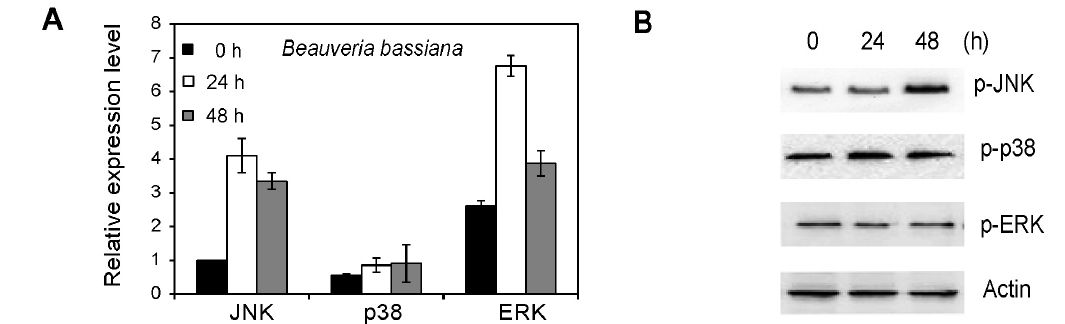
Figure 7. Effects of fungal treatment on MAPK. ( A ) qRT-PCR analysis of JNK, p38 and ERK in whiteflies treated with fungal for 0, 24 and 48 h; ( B ) Phosphorylation of JNK, p38 and ERK in whiteflies treated with fungal for 0, 24, 48 h. Each symbol and vertical bar represents the mean ± SD ( n =